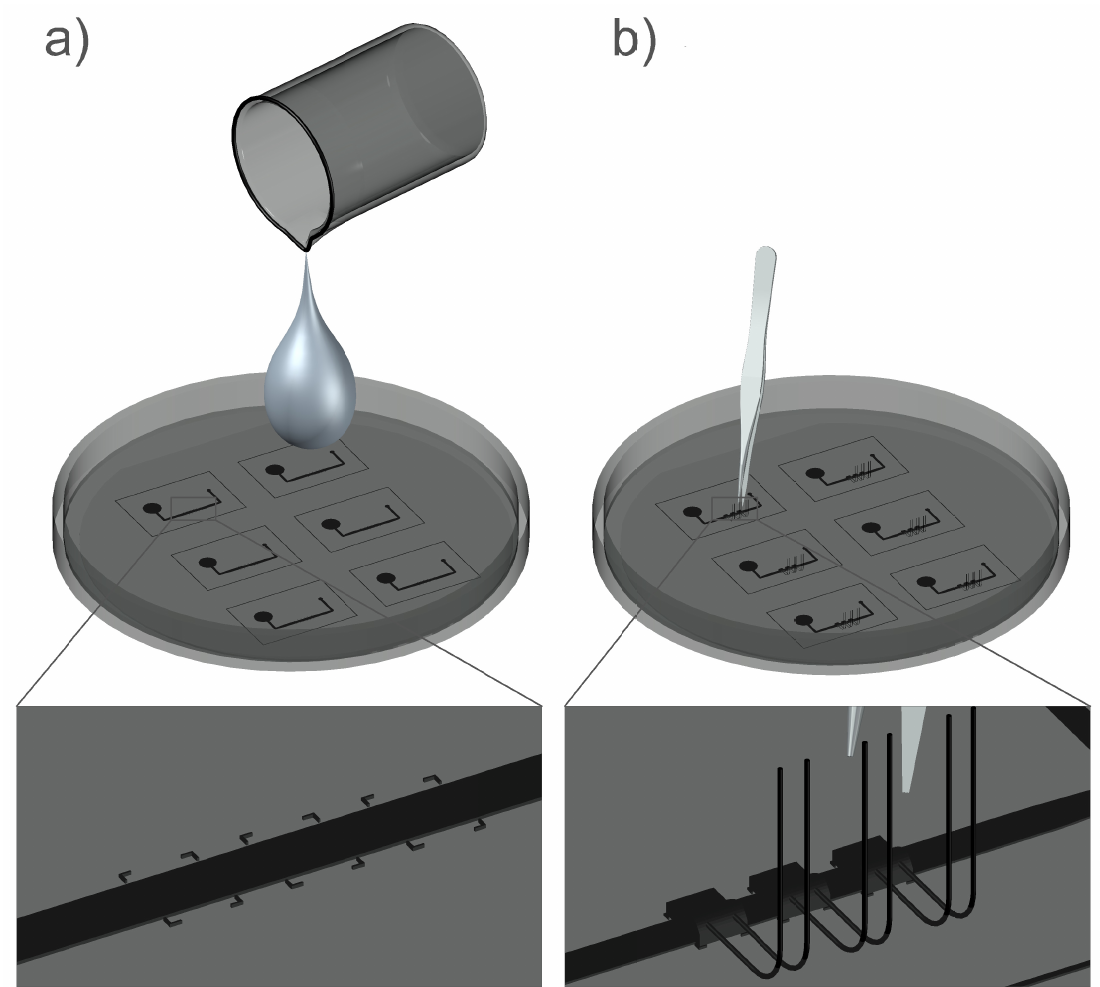
Figure 3. Two crucial steps of the rapid prototyping embedding technique for a flowmeter fabrication: ( a ) pouring of the degassed PDMS elastomer onto the Si mold; ( b ) manual alignment of platinum elements to the dedicated markers along the